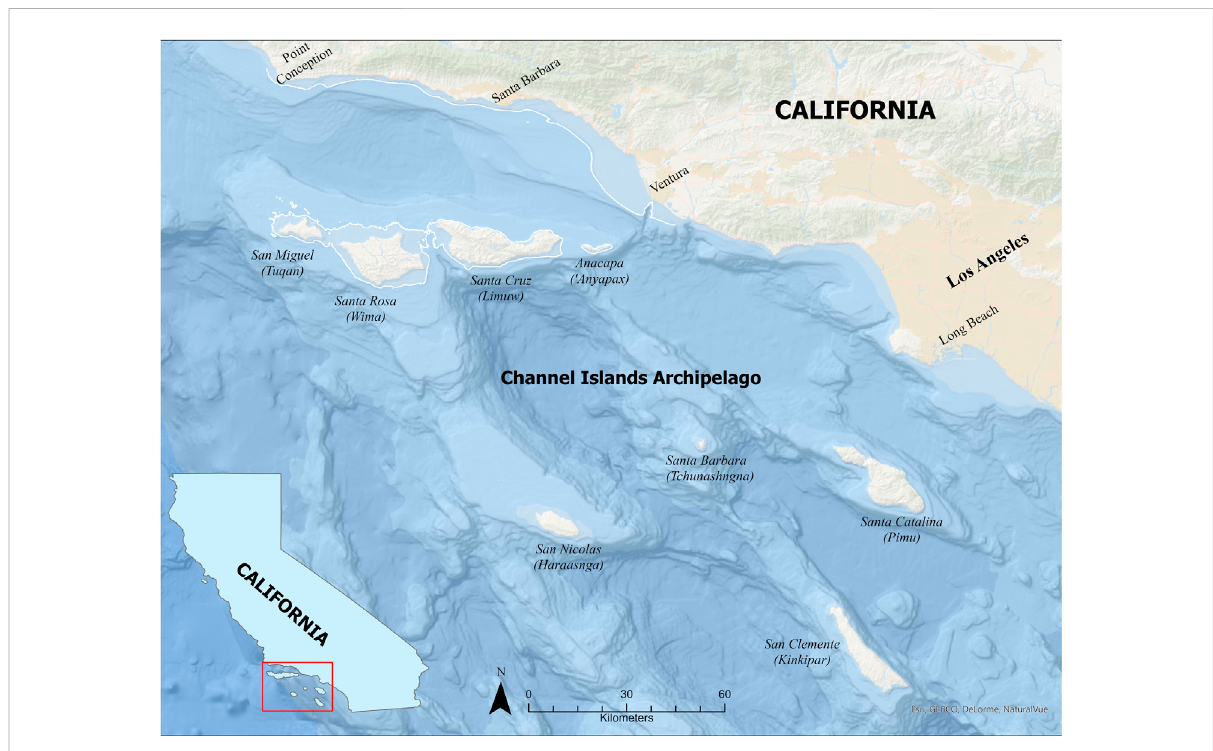
FIGURE 1 Map of the northern portion of the Southern California Bight and the Channel Islands archipelago showing both the southern and northern groups.White boundaryaroundtheNCIisthe70 misobathshowingthegeneralextentofSantarosaeandtheadjacentmainland~13,000